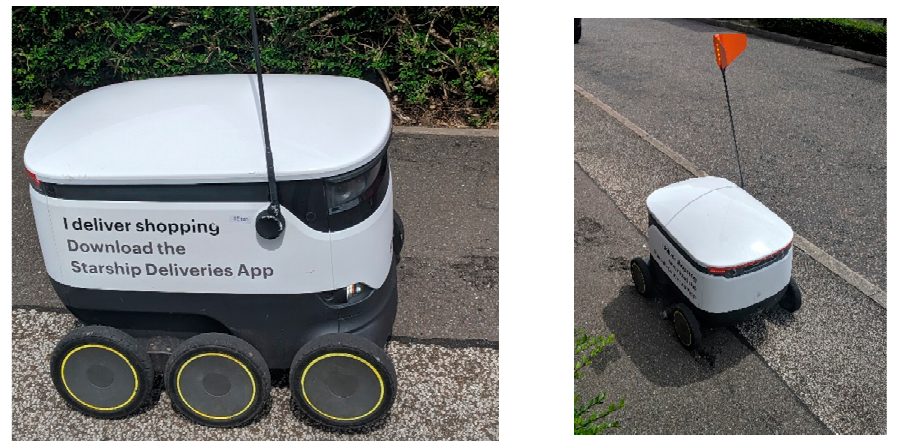
Figure 11. A delivery Robot around the Kent’s Hill district. The first image illustrates how the delivery Robots move across the Redways and pavements, and in the second photo, there is an orange flag which can be found on all Robots. Permission granted by Marston.